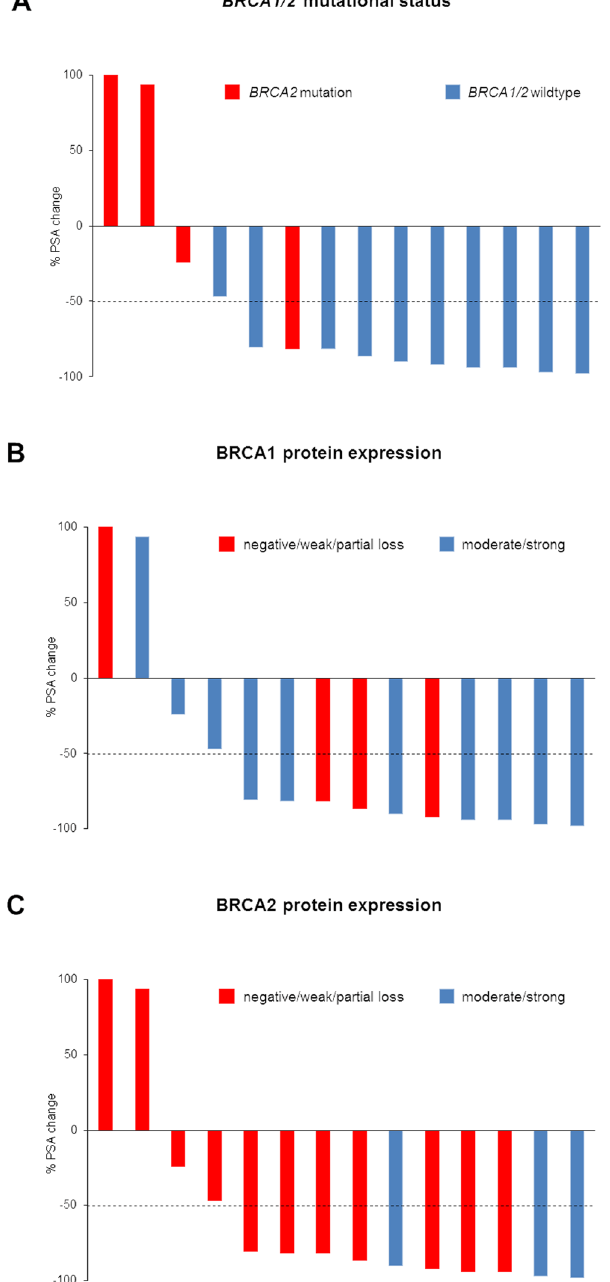
Figure 4. Correlation of BRCA1 / 2 mutational status or BRCA1/2 protein expression to the PSA response to docetaxel. Waterfall plots for the percentage PSA change after docetaxel treatment stratified into BRCA1 / 2 mutation status ( A ), BRCA1 protein expression ( B ) or BRCA2 protein expression ( C ). The dotted line indicates the threshold for defining a PSA response (PSA decline ≥ 50%). The y axis was cut off at